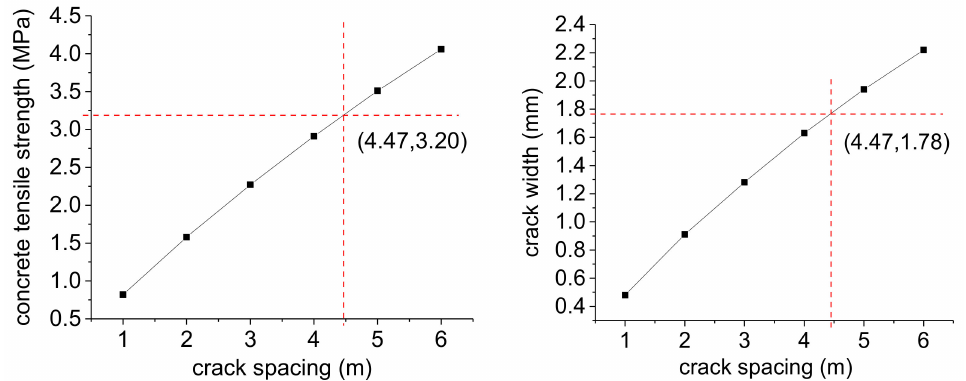
Figure 6. Predictions of the crack spacing ( left ) and crack width ( right ) in CRCP with BFRP bars.